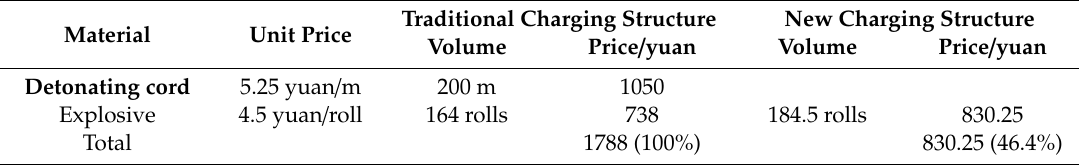
Table 3. Comparison of economic